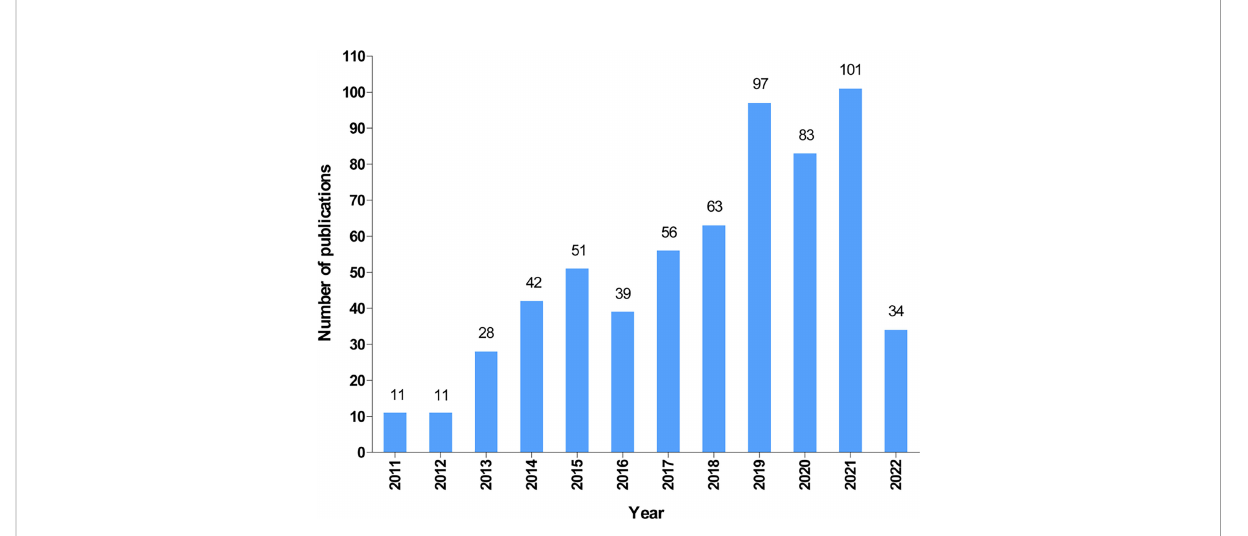
FIGURE 2 The annual output of autophagy and pancreatic cancer from 2011 to